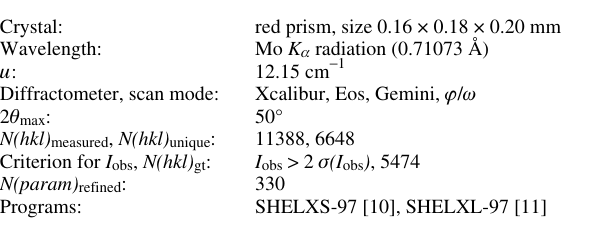
Table 1. Data collection and handling.